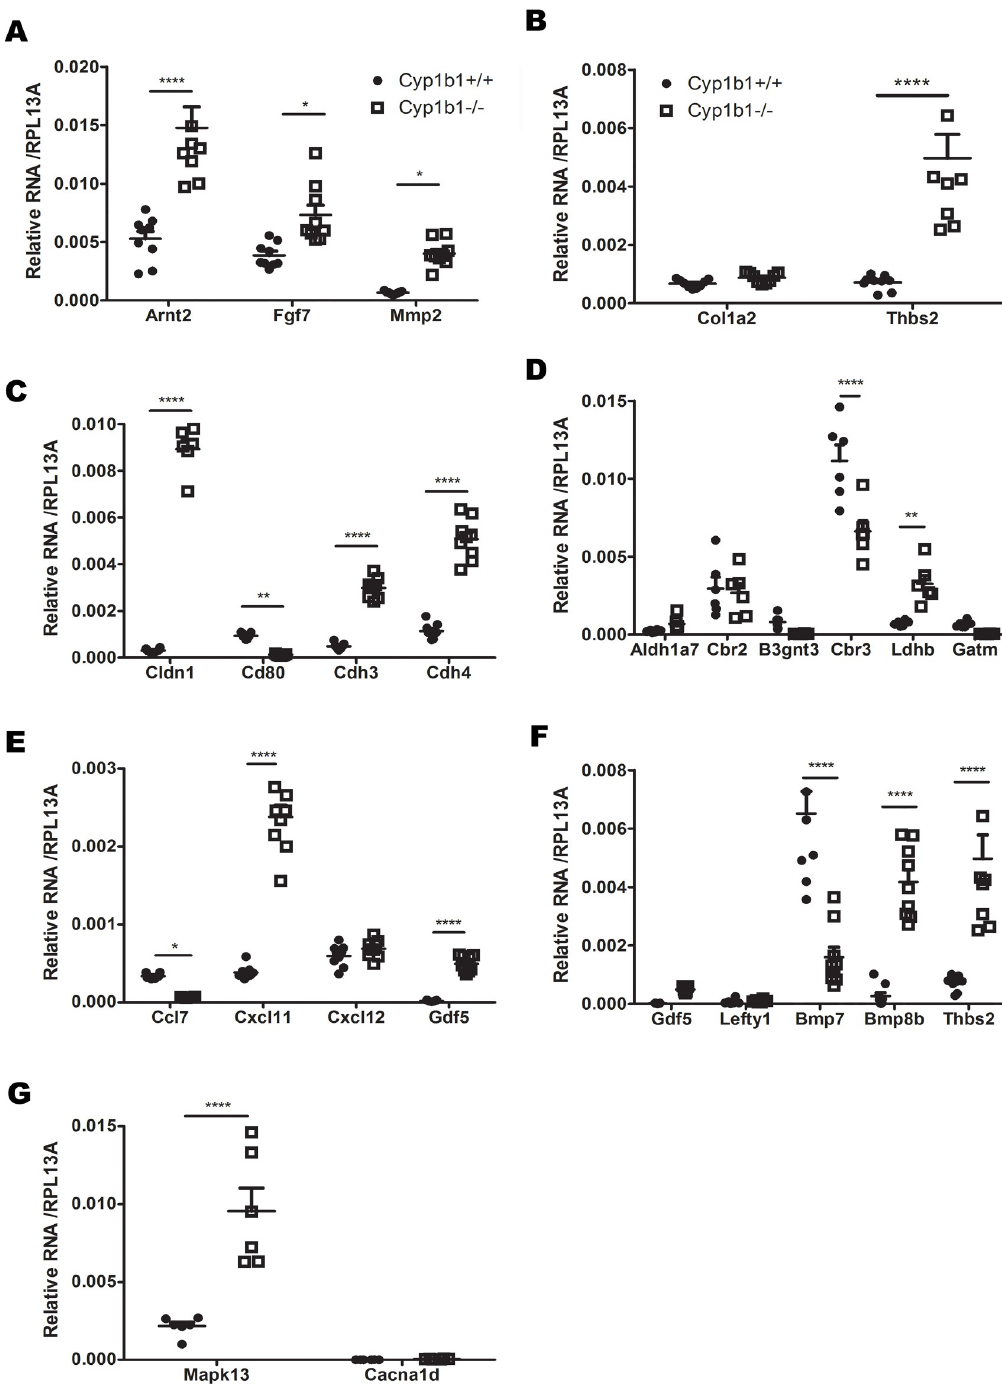
Fig 4. RT-qPCR validation of DEG from different pathways. (A) Genes related to the Cancer pathway. (B) Genes related to the ECM-Receptor and Focal adhesion pathways. (C) Genes related to the Cell adhesion molecules pathways. (D) Genes related to the metabolic pathways. (E) Genes related to the Cytokine-Cytokine interaction pathways. (F) Genes related to the TGF- β signaling pathway. (G) Genes related to the MAPK signaling pathways. ( � P < 0.05, �� P < 0.01, ���� P < 0.0001, n � 6).